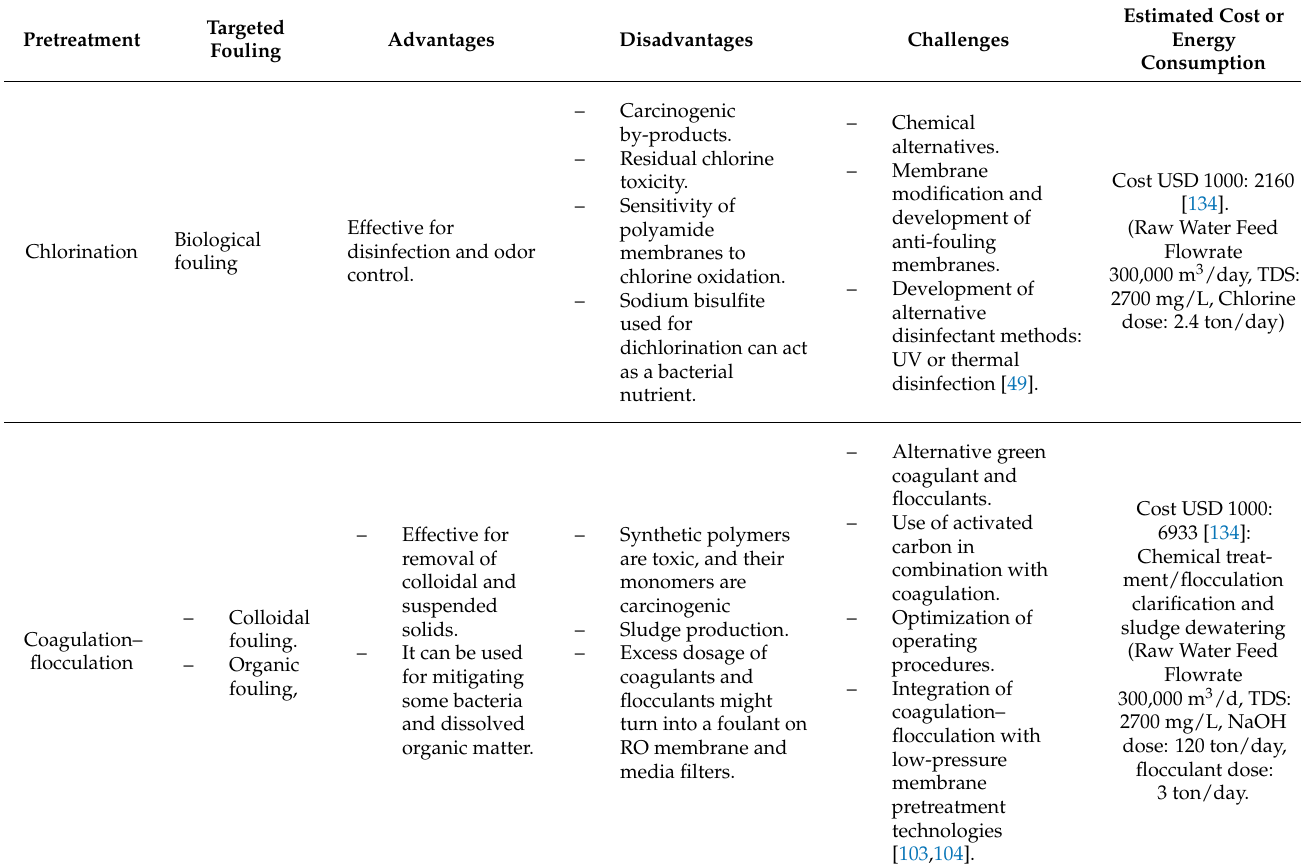
Table 5. Summary of common conventional RO pretreatment